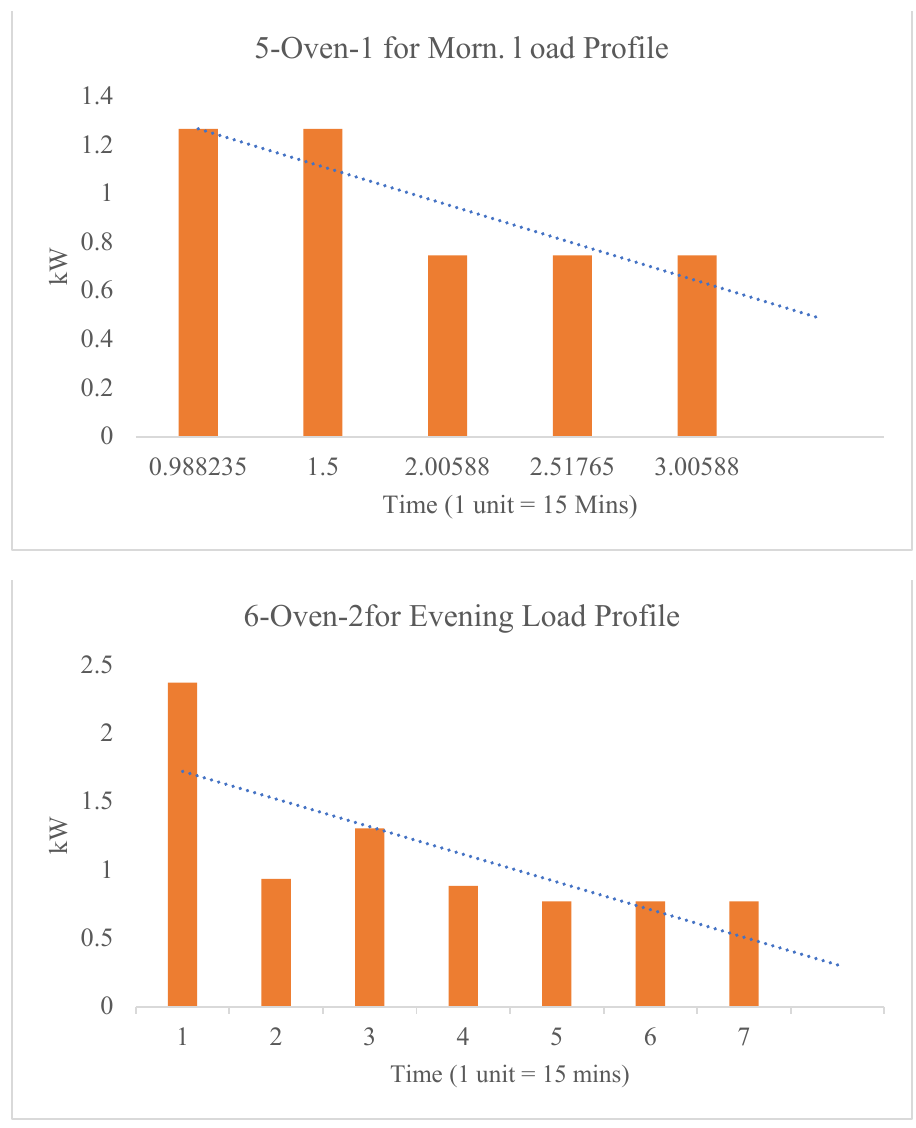
Figure 8. Load profile of oven for evening and morning.